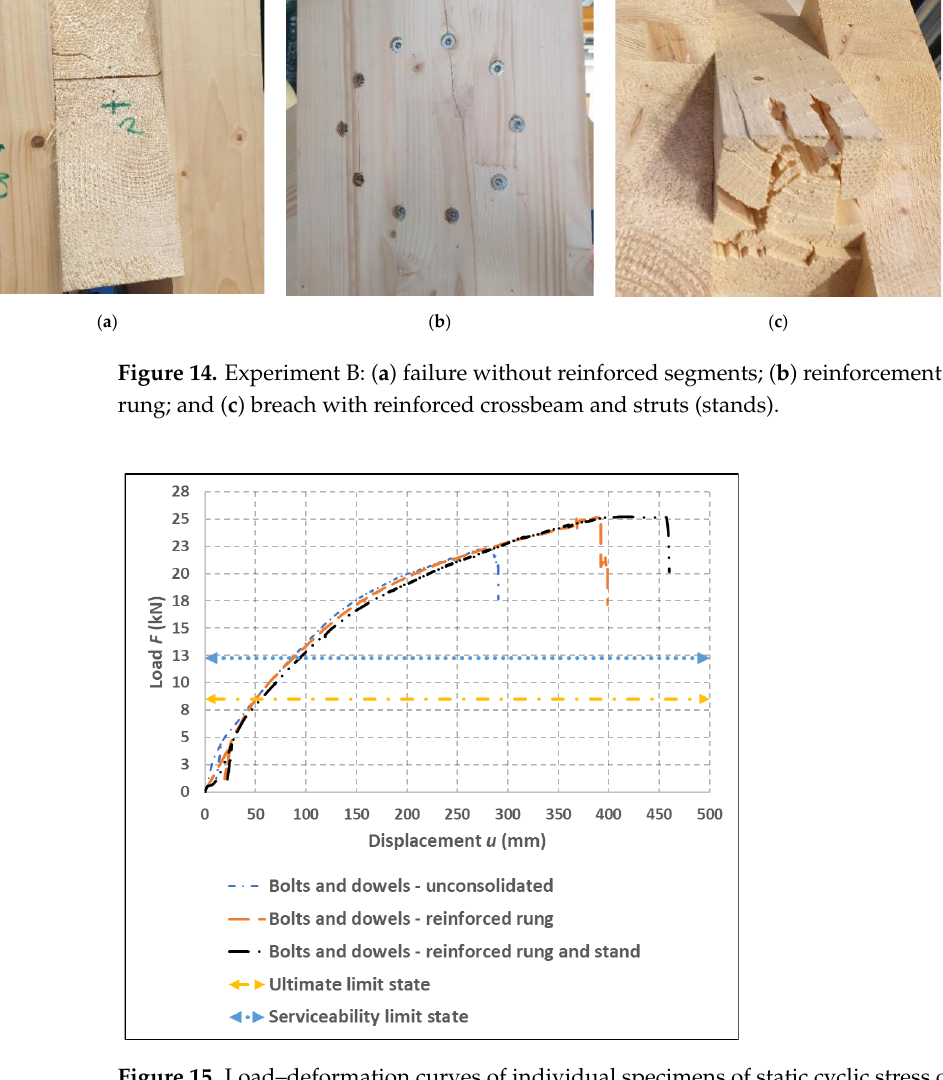
Figure 16. Load – deformation curves of individual specimens of static cyclic loading of experiment B, using full-threaded screws. The results of individual tests are recorded in the tables below. Table 5 presents the results of the semirigid connection of experiment A, using bolts and dowels. Table 6 pre- sents the results of experiment B, using full-threaded screws. The first column (Test) in